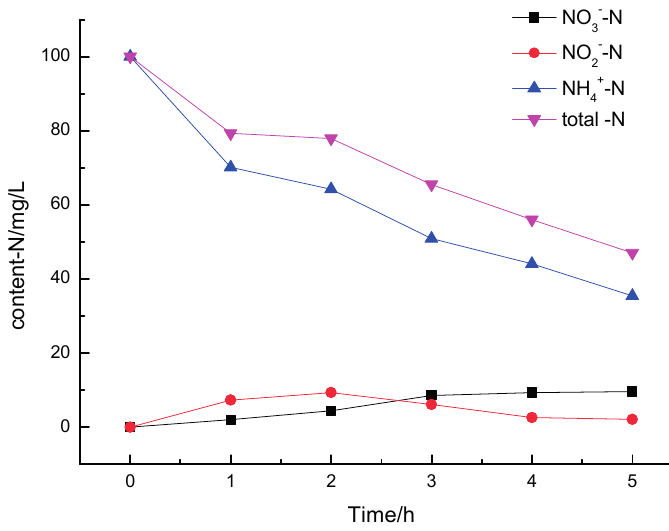
Figure 8. The conversion curves of the NH 4+ -N during the photodegradation